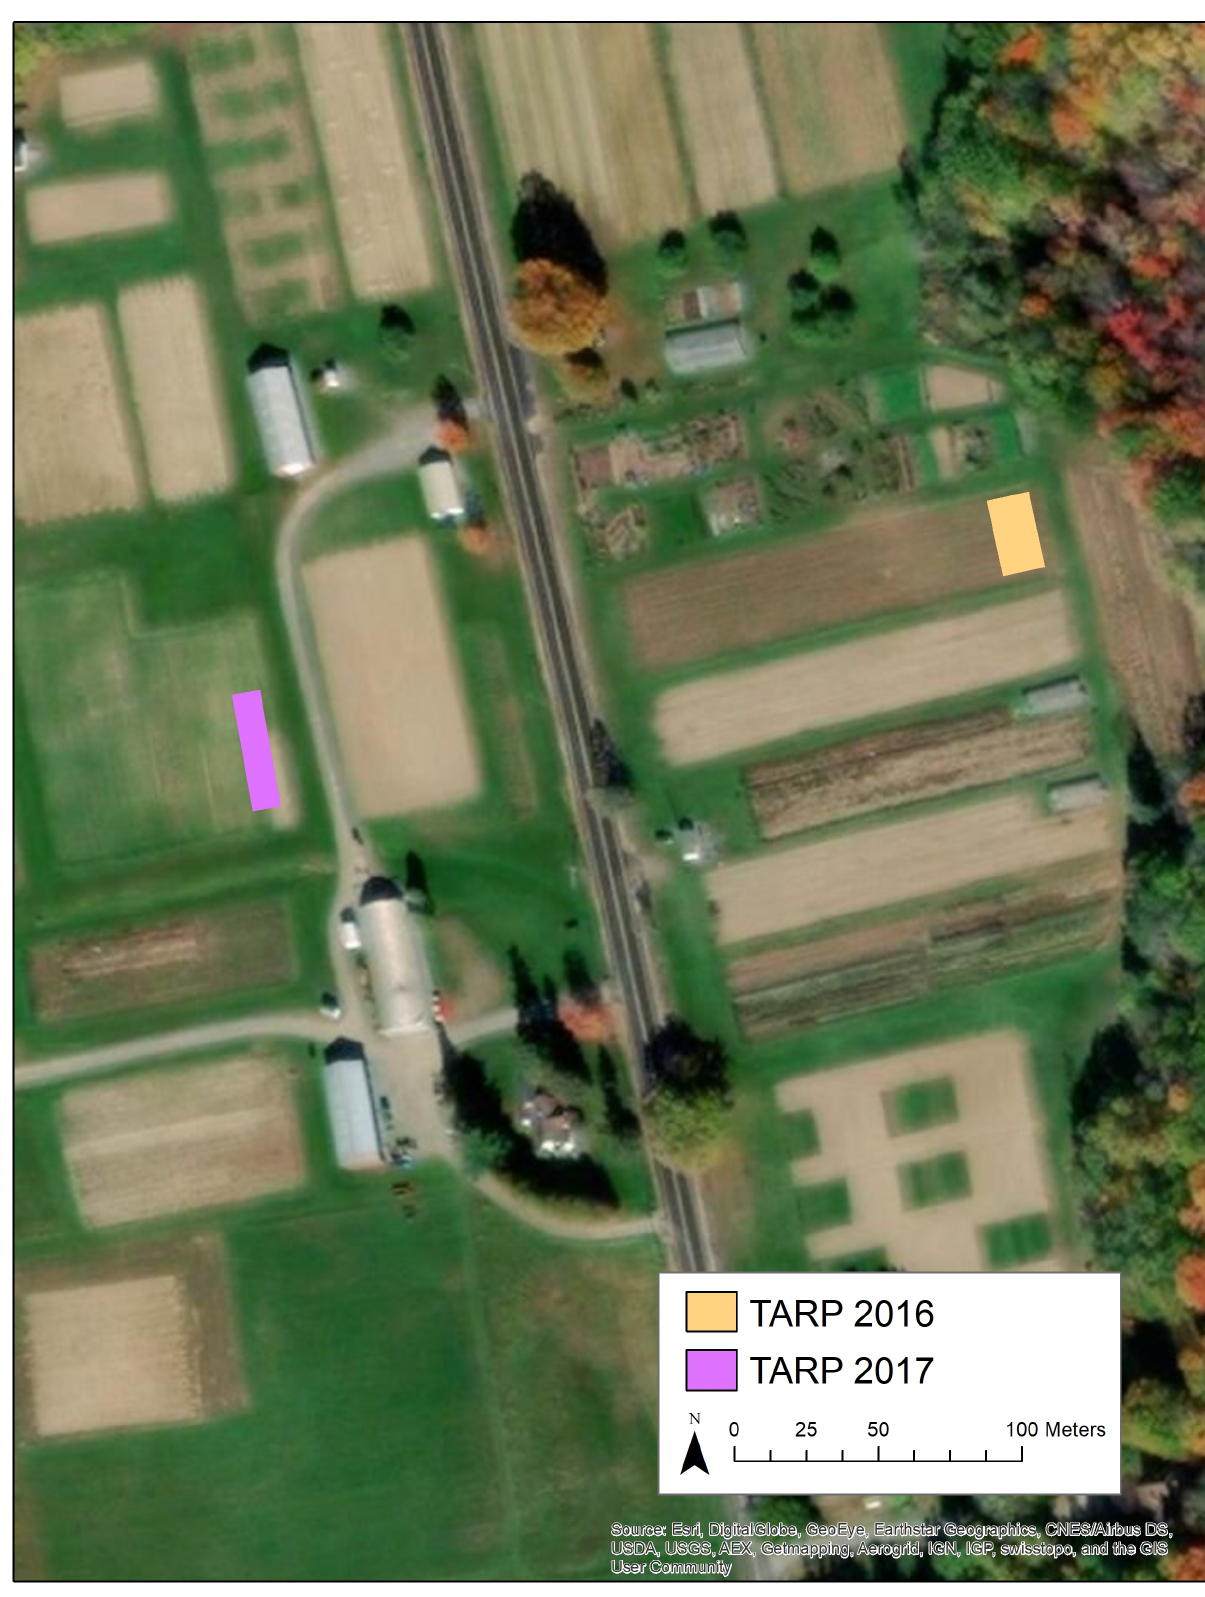
Figure A3. Aerial view showing locations of TARP experiments conducted during the summers of 2016 and 2017 to compare solarization and